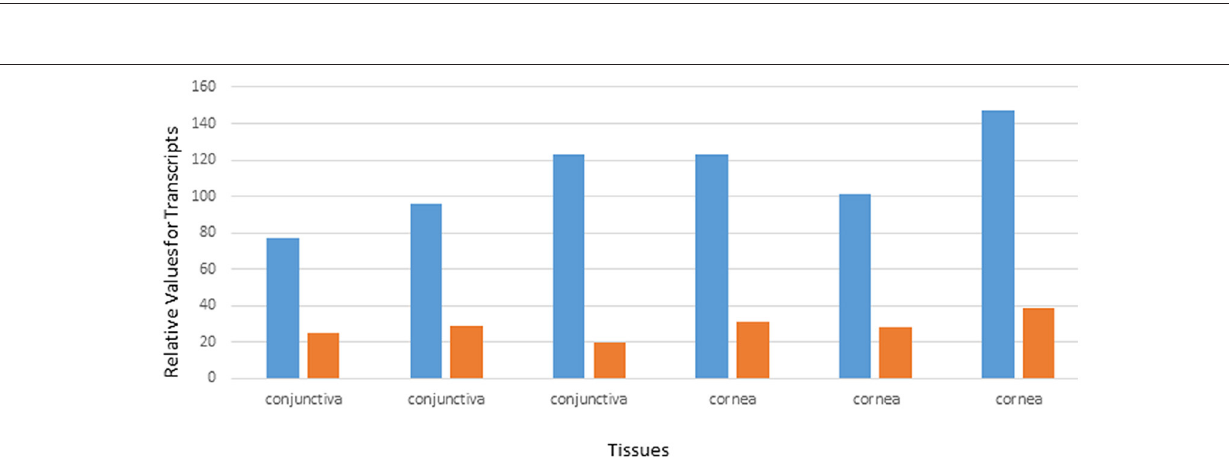
FIGURE 6 | Relative values of expression transcripts for tear lipocalin (orange) vs. lipocalin-interacting membrane receptor (blue) for cornea and conjunctiva samples. The data are adapted from GDS profile 2682 in the gene expression